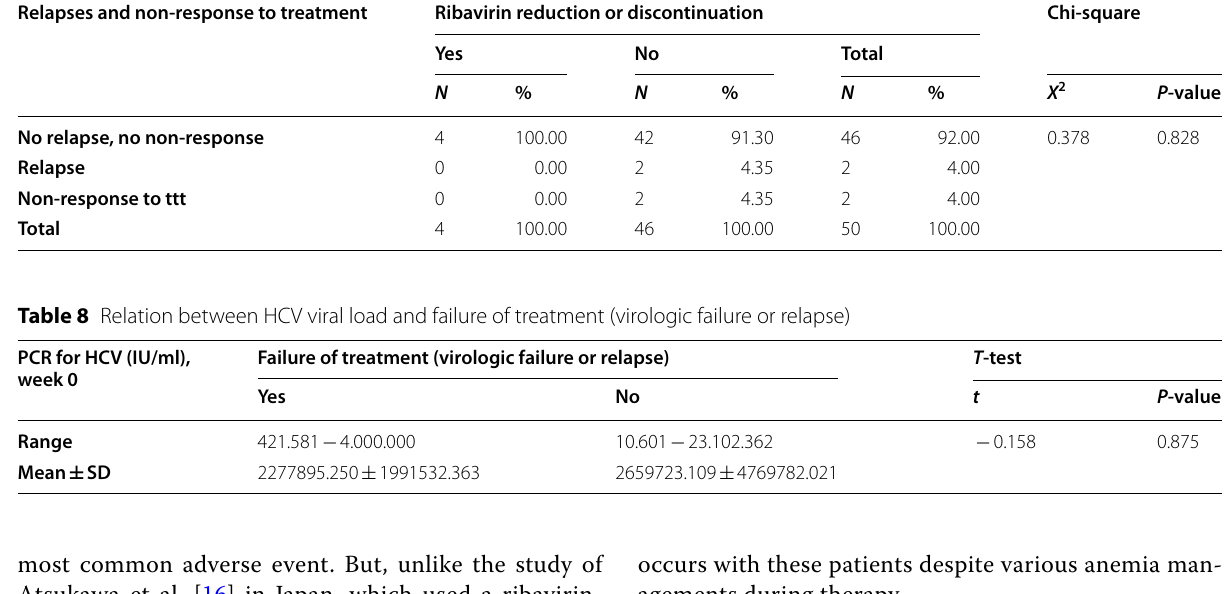
Table 7 Correlation between ribavirin dose reduction or discontinuation and relapse/non-response to treatment Relapses and non-response to treatment Ribavirin reduction or discontinuation Chi-square